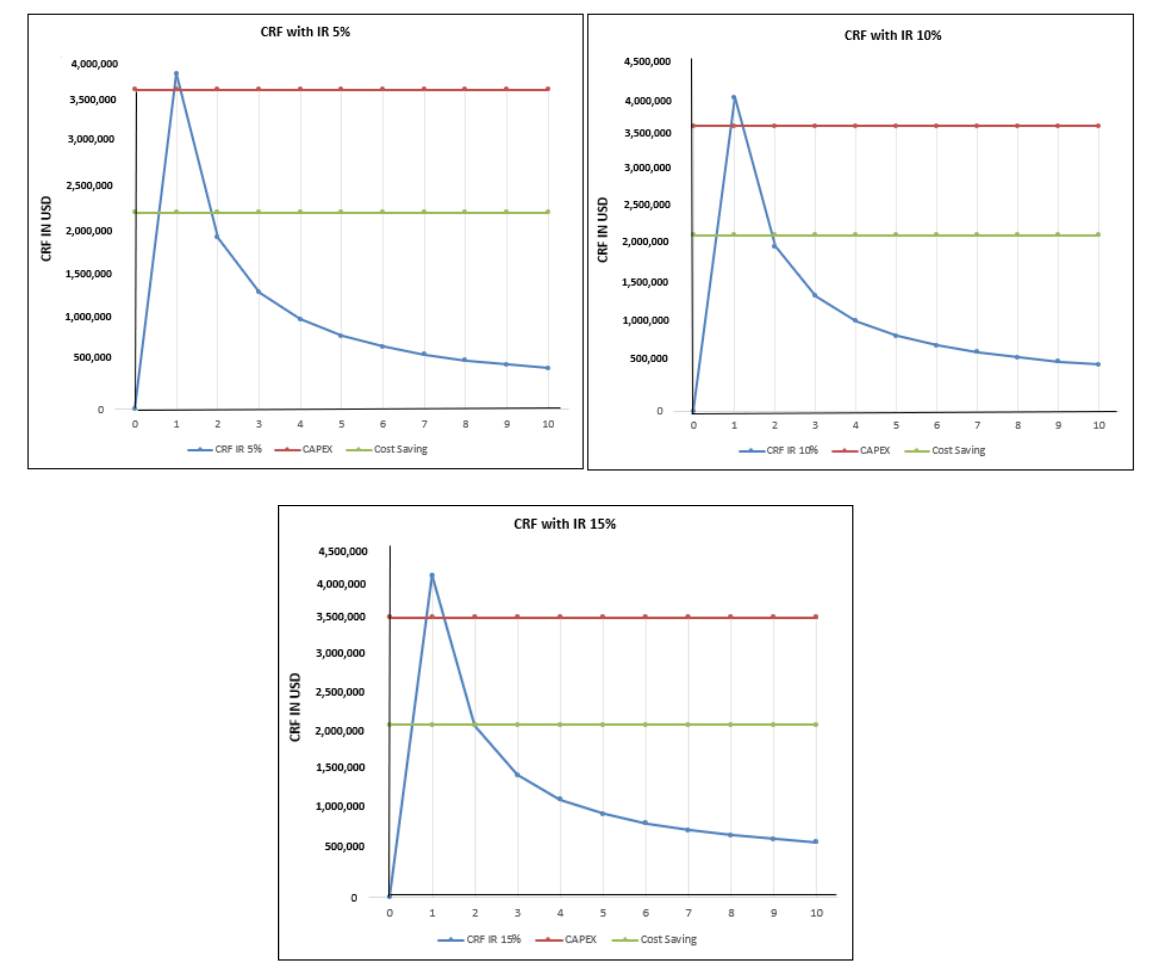
Figure 14. Capital Recovery Factor for 600 TEU with various interest.